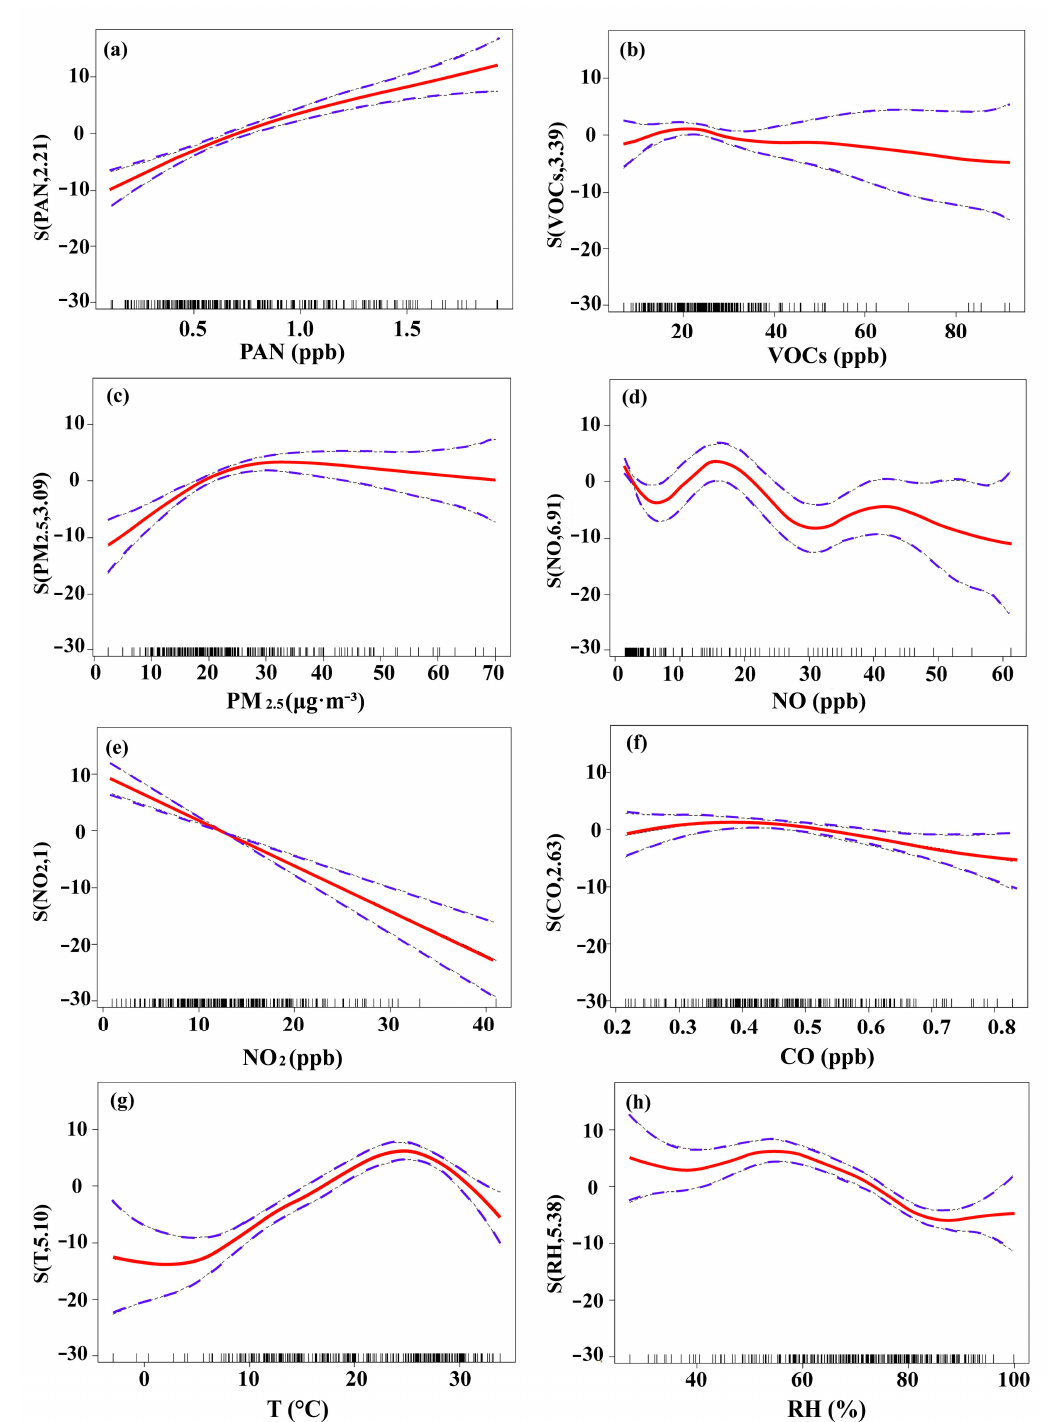
Figure 4. Response curves in the multiple-factor model of O 3 to changes in ( a ) PAN, ( b ) VOCs, ( c ) PM 2.5 , ( d ) NO, ( e ) NO 2 , ( f ) CO, ( g ) T, and ( h ) RH. The y axis shows the smoothing function values. For example, S (PAN, 2.21) shows the trend in PAN when O 3 changes, and 2.21 is the degree of freedom. The x axis is the influencing factor. Note that each marginal effect is denoted by a solid red line with a 95% confidence interval (purple dashed lines), and the vertical lines adjacent to the lower x-axis represent the distributions of these